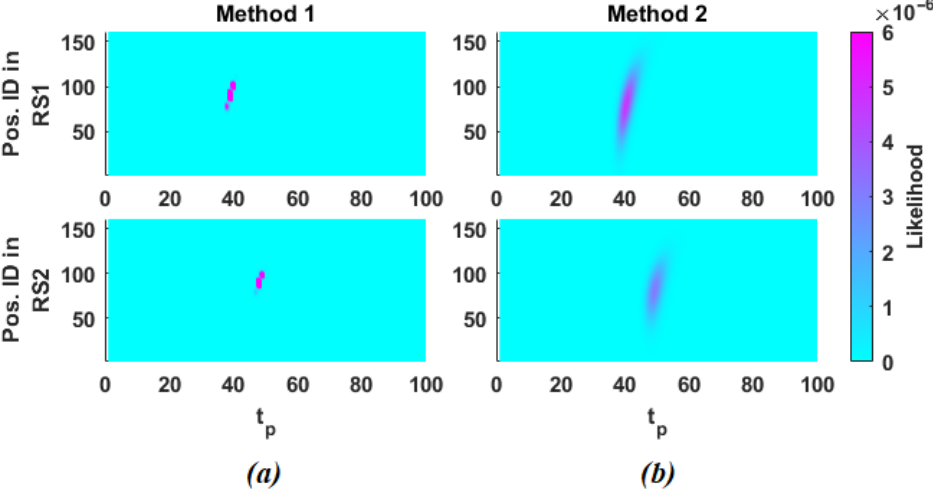
Figure 8. An example of the likelihood of reachable sets where t α = 7, MC Run No. 71. ( a ) Method 1, ( b ) Method